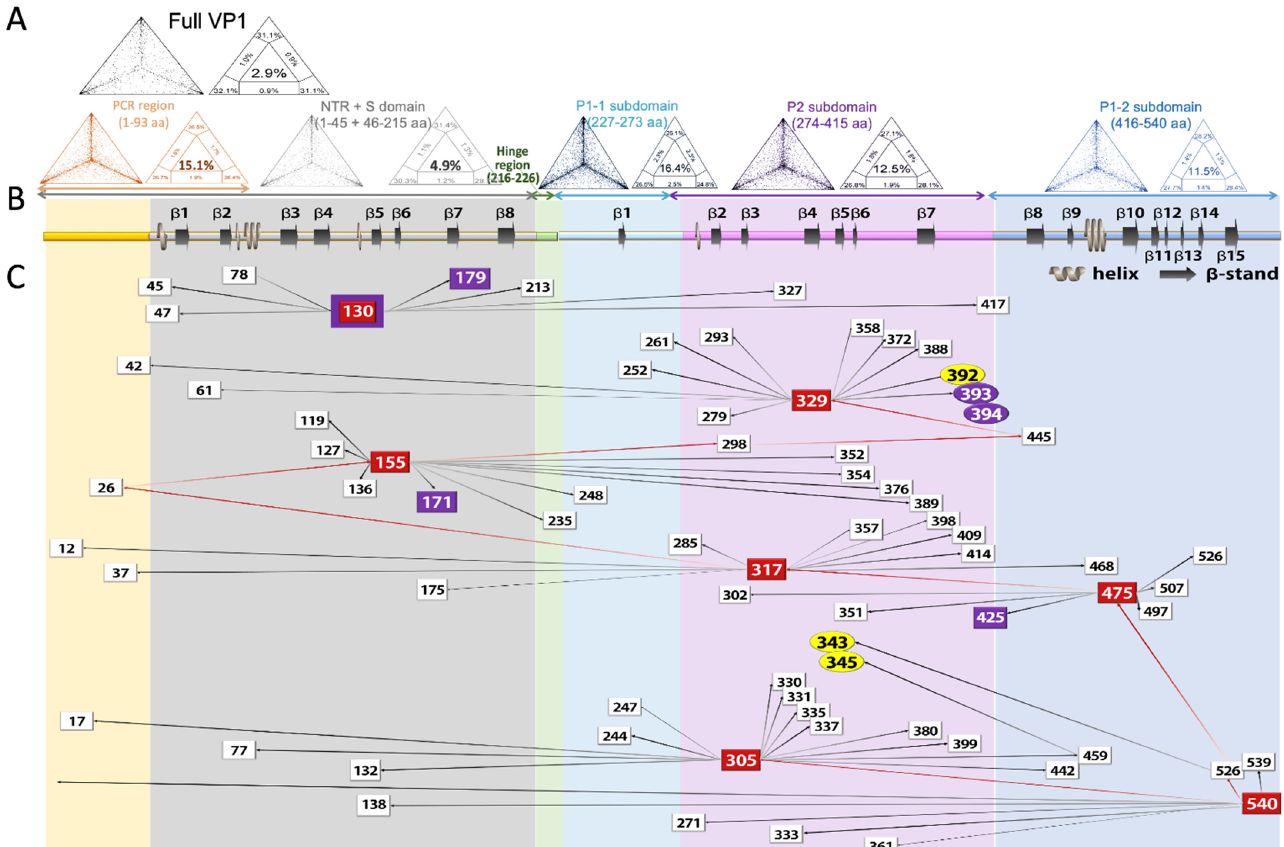
Figure 4. Likelihood mapping, sequence logos, and epistasis analysis of norovirus VP1 sequences. ( A ) Likelihood mapping diagrams of full VP1, S domain, P1-1, P2, and P1-2 domains are shown in the first panel. In the left triangle, each dot represents the likelihoods of three possible unrooted trees out of 10,000 random quartets. The right triangle shows the seven basins of attraction with their corresponding attractors. The numbers indicate the percentage of quartets falling in each region. Numbers in the center area of the triangle correspond to phylogenetic noise; when the number was less than 10%, the data were considered reliable for phylogenetic inference. Likelihood mapping graphics were produced by the TREE-PUZZLE program v5.2. ( B ) The secondary structure guide is located at the third panel (PDB ID code 6ouu). ( C ) Multiple epistatic interactions are shown at the bottom of the figure. Each square represents a residue position that participates in at least one interaction with a marginal posterior probability (PP) exceeding a default cutoff of 0.5. Only epistatic interaction with HBAG binding site (highlighted with yellow cycle), phosphorylation sites (highlighted with purple box), and epistatic interaction group no less than seven (highlighted with red box) are shown. Arrows between squares indicated the epistatic direction between residues, the direction was also enhanced by color level from light to darkness, the PP values are indicated by the line weight. An epistatic network has been shown by the key dominant site position 540.